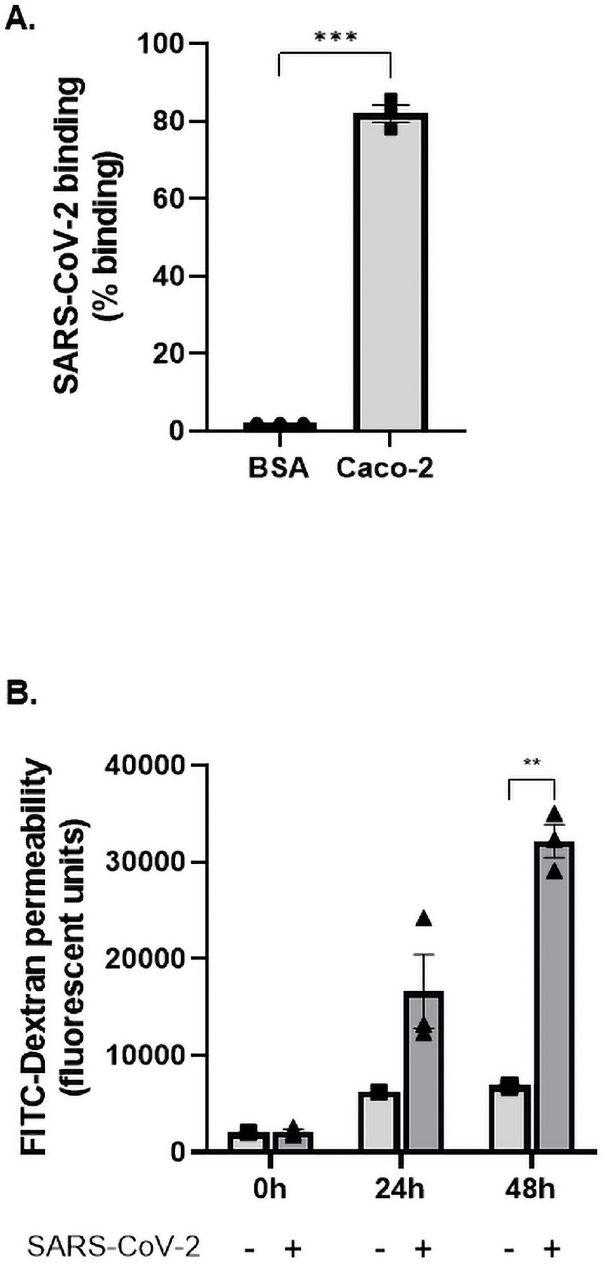
Fig 1. SARS-CoV-2 binds to human epithelial cells and causes permeability. (A) SARS-CoV-2 (1.08 x 10 5 TCID50/ mL) was added to either a control surface (BSA) or human epithelial cells (Caco 2). Cells were allowed to adhere to immobilised SARS-CoV-2 and lysed with pNPP, a fluorescent substrate against alkaline phosphatase expressed within cells. The fluorescent signal emitted by pNPP correlated to the number of cells adhered and was read at 405 nm. Epithelial cells significantly interacted with SARS-CoV-2 (P < 0.001; paired t-test, N = 3). (B) Caco-2 was seeded onto transwell inserts and infected with SARS-CoV-2 at MOI = 0.4. Permeability was measured using Fluorescein isothiocyanate-dextran (FITC-Dextran, 40kDa) across 0 hours, 24 hours, and 48 hours. FITC-Dextran passes through the epithelial cells into the lower chamber and is proportionate to their permeability. The extent of permeability was measured by quantifying the fluorescent levels of FITC-Dextran at 490/520 nm. Cell permeability significantly increased throughout the time course (P < 0.01; P < 0.0001; ANOVA f-value = 46.84, N = 3).